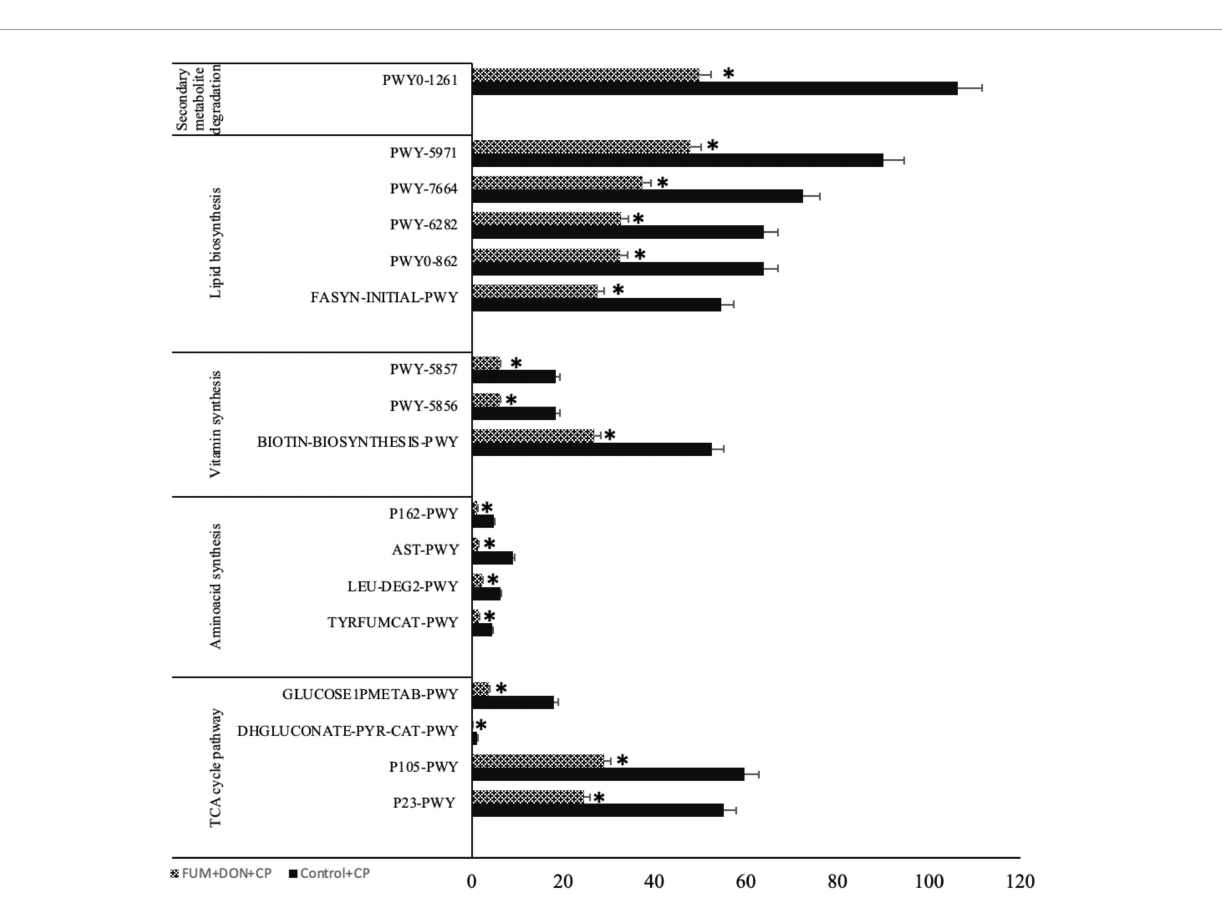
FIGURE10 Microbial function analysis: Broilers were fed control or mycotoxin (FUM 3 mg/kg diet + DON 4 mg/kg diet). All birds received 1 × 10 8 CFU/bird of C. perfringens on d 19 and 20. Cecal digesta was analyzed SCFA at 1, 7, and 14 days post-infection. P23-PWY: Reductive TCA cycle I; P105-PWY: TCA cycle IV (2-oxoglutarate decarboxylase); DHGLUCONATE-PYR-CAT-PWY: Glucose degradation (oxidative); GLUCOSE1PMETAB-PWY: Glucose and glucose-1-phosphate degradation; TYRFUMCAT-PWY: L-tyrosine degradation I; LEU-DEG2-PWY: L-leucine degradation I; AST-PWY: L-arginine degradation II (AST pathway) (AST-PWY); P162-PWY: L-glutamate degradation V ( via hydroxyglutarate); BIOTIN-BIOSYNTHESIS-PWY: Biotin Biosynthesis I; PWY-5856: Cofactor, Carrier, and Vitamin Biosynthesis; PWY-5857: Cofactor, Carrier, and Vitamin Biosynthesis; PWY-5971: Palmitate Biosynthesis; PWY-6282: Fatty Acid and Lipid Biosynthesis; PWY-7664: Fatty Acid and Lipid Biosynthesis; FASYN-INITIAL-PWY: Fatty Acid and Lipid Biosynthesis; PWY0-1261: Secondary metabolite degradation. Bars (+SEM) with no common superscript differ significantly. Asterisks denote significant difference ( ∗ P < 0.05) n =